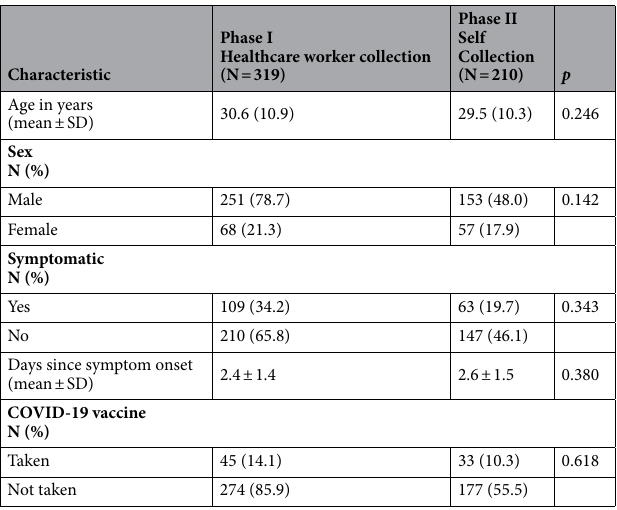
Table 1. Characteristics of study participants.